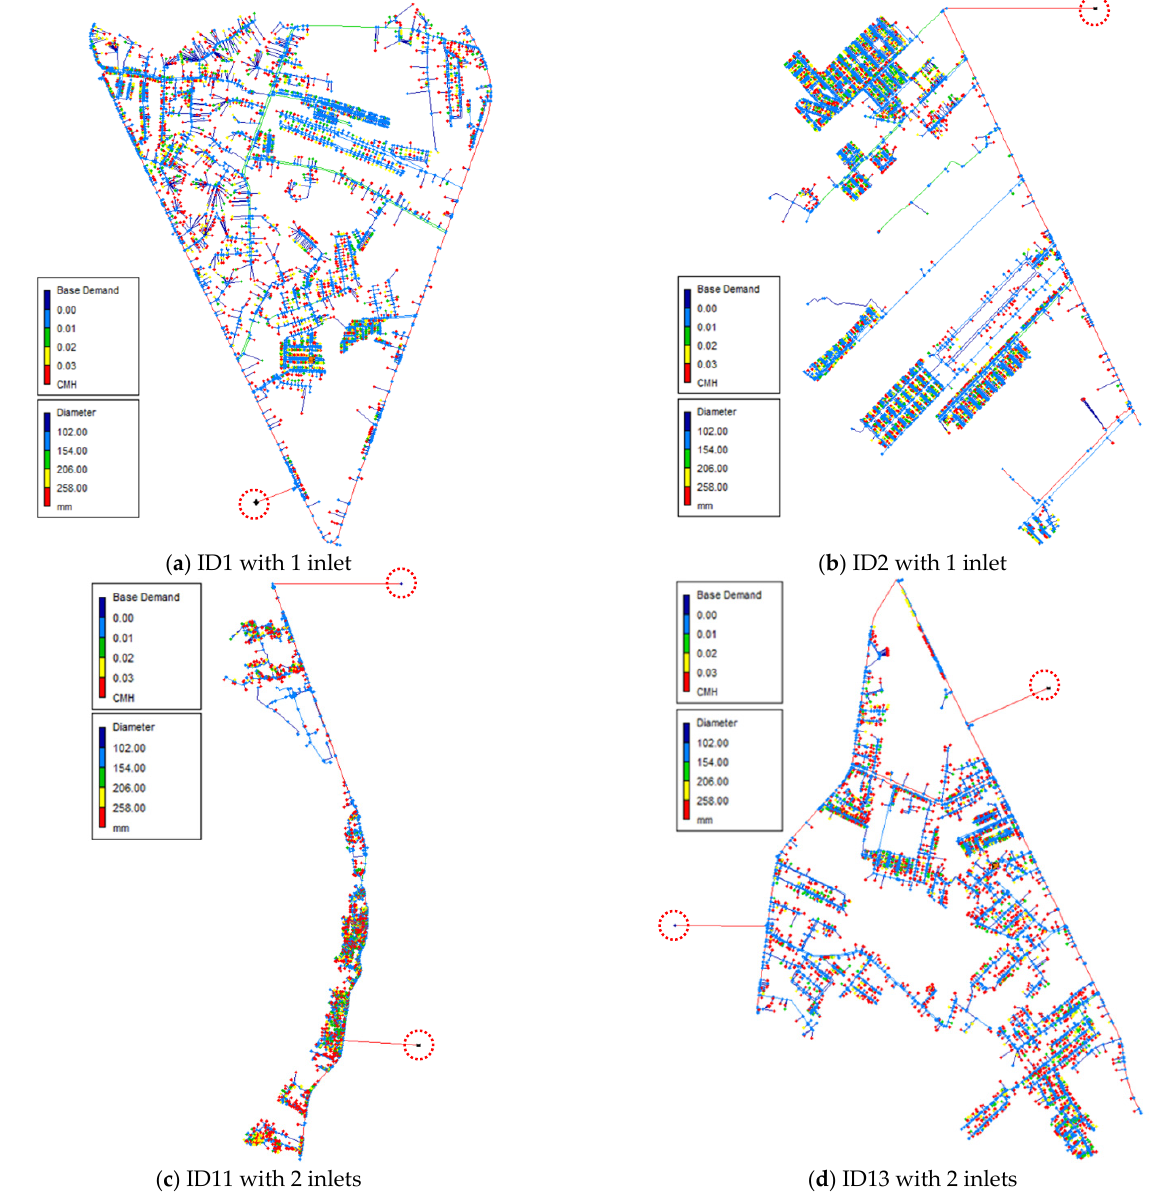
Figure 5. Examples of water networks, where ( a , b ) are networks with 1 inlet, and ( c , d ) are networks with 2 inlets. Red dashed circles show the inlets connecting to the networks by imaginary valves with no friction loss.